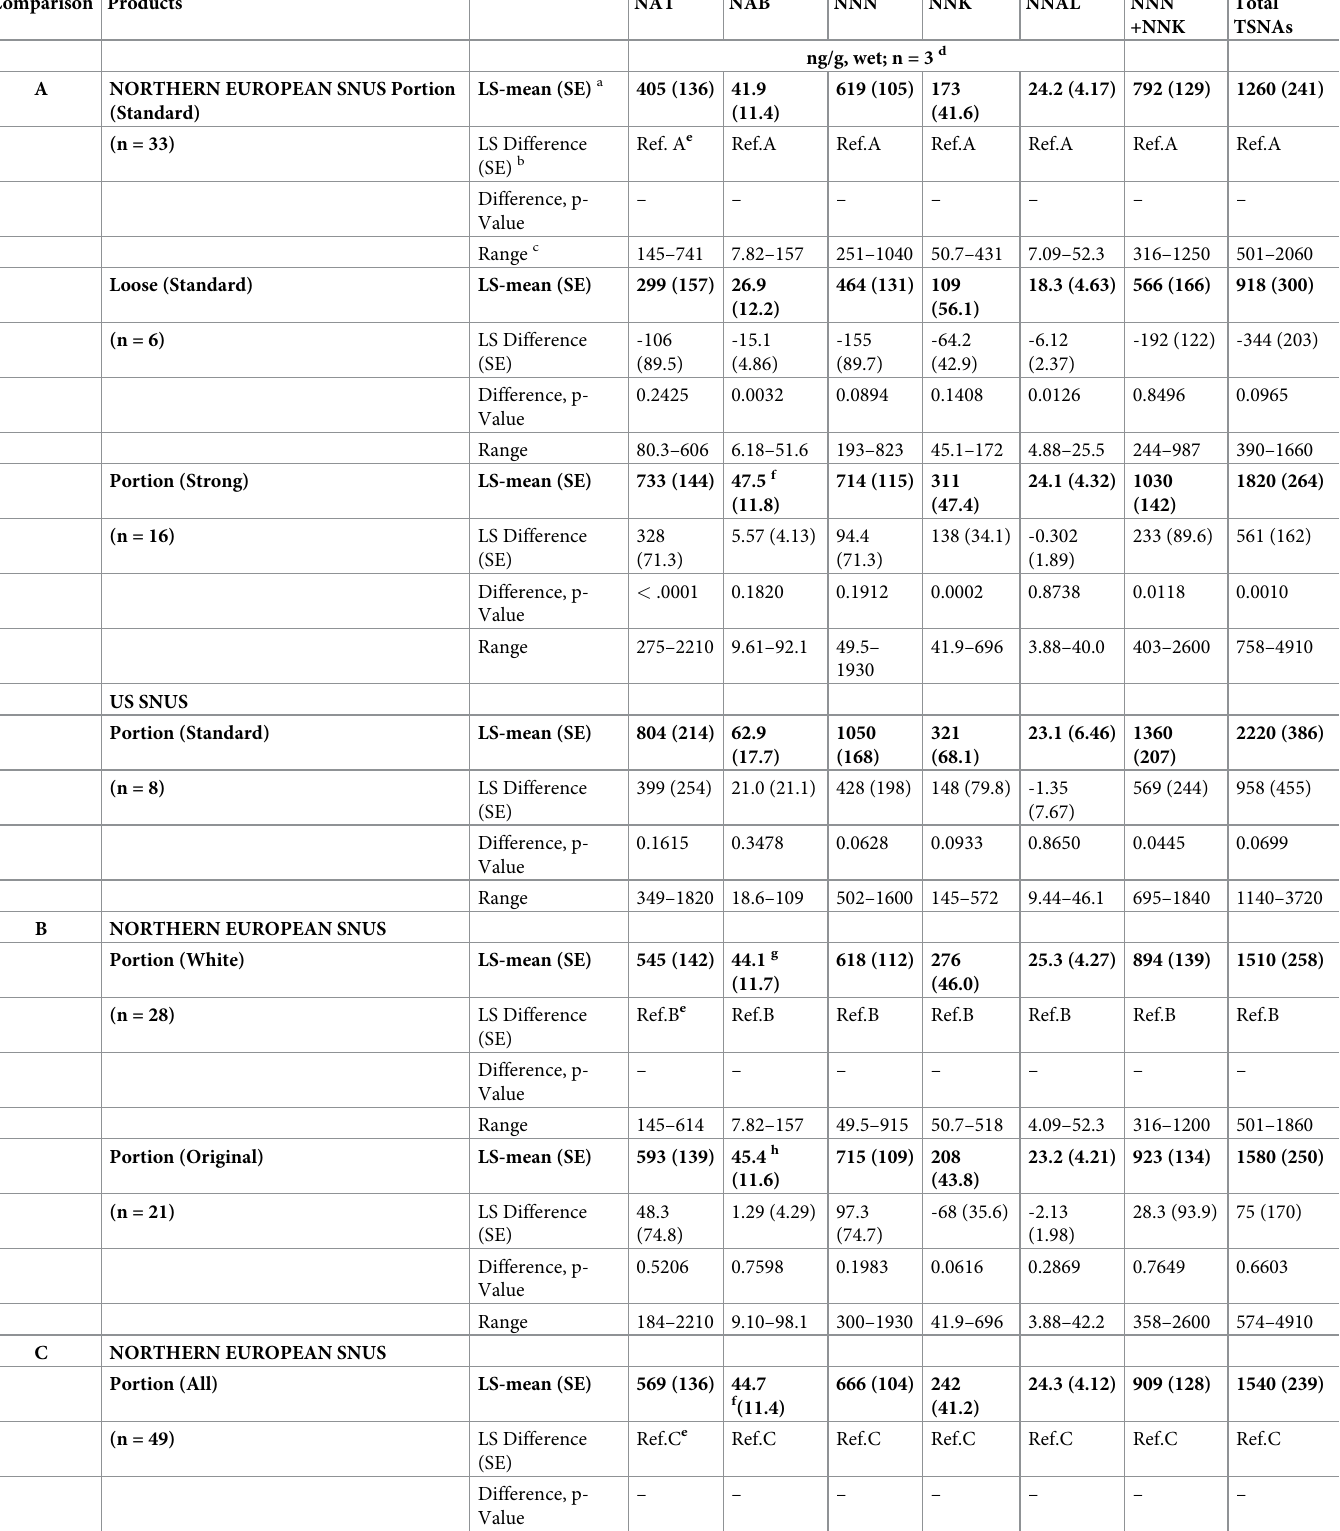
Table 2. Least-square means of five tobacco-specific N’-nitrosamines in snus categorized by region and product type. Comparison